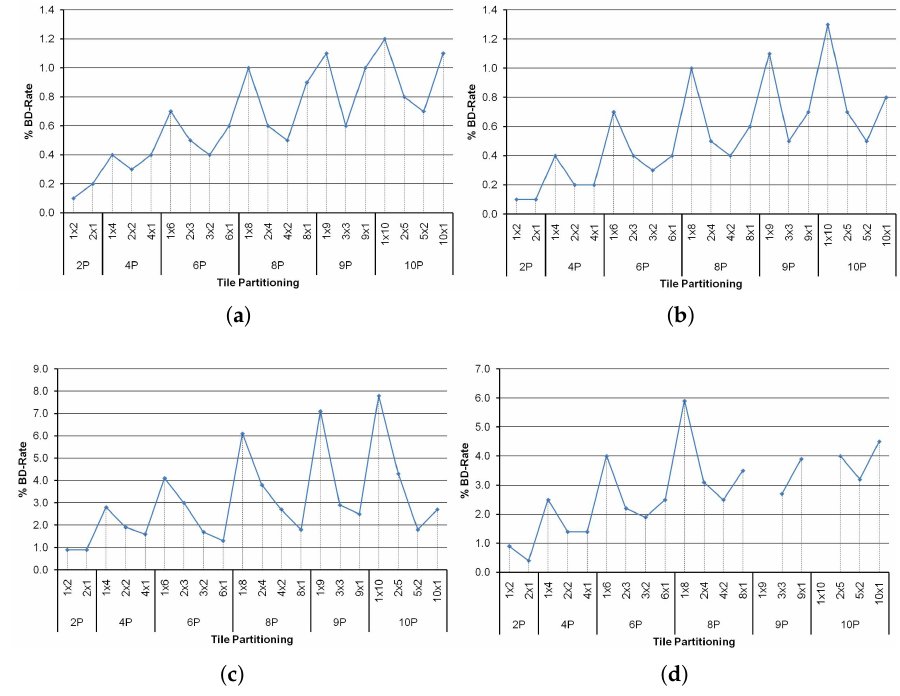
Figure 10. Tile-based BD-Rate with different number of processes and tile partitioning for all QPs. ( a ) PeopleOnStreet (2560 × 1600); ( b ) Tennis (1920 × 1080); ( c ) Kristen&Sara (1280 × 720); ( d ) BasketballDrill (832 × 480).